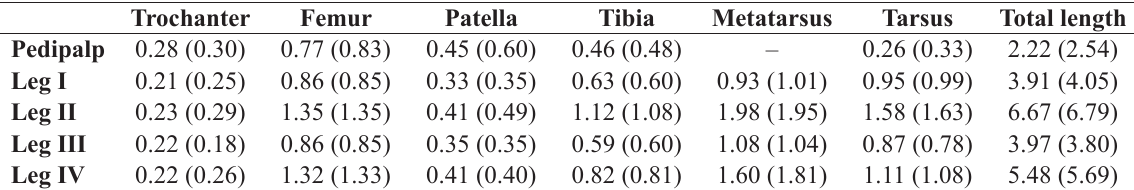
Table 11. Length of appendage-segments in millimeters in N. bidentatum schmidti Novak, Raspotnig & Slana Novak ssp. nov. from Dolenja Sevnica, Slovenia: ♂ holotype